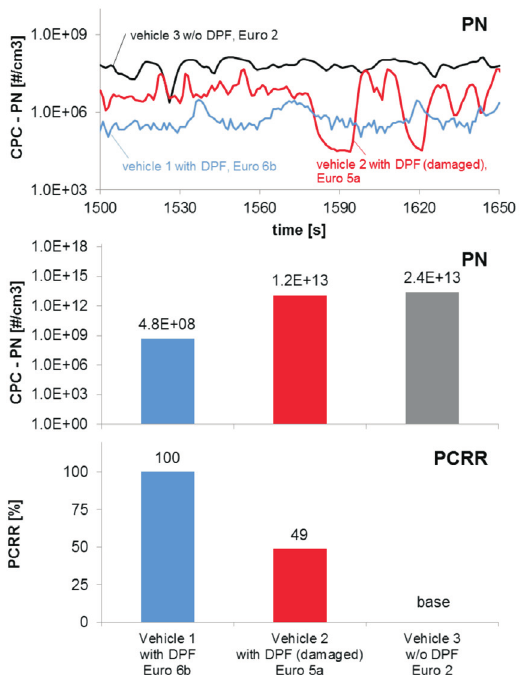
Fig. 13. Effects of DPF on Diesel Passenger Cars in WLTC (hot) Succes of DPF